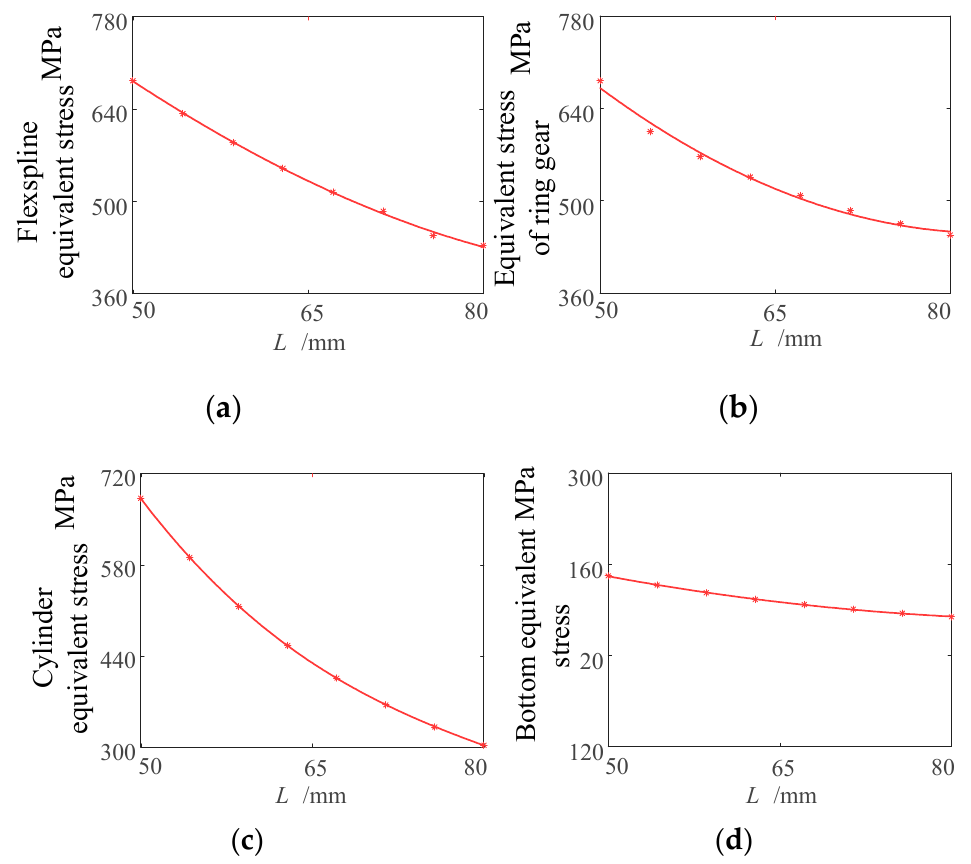
Figure 18. Stress influence curve of different round length flexible wheels. ( a ) Stress variation curve of flexspline; ( b ) Stress change curve of the ring gear; ( c ) Cylinder stress change curve; ( d ) Bottom stress variation curve.